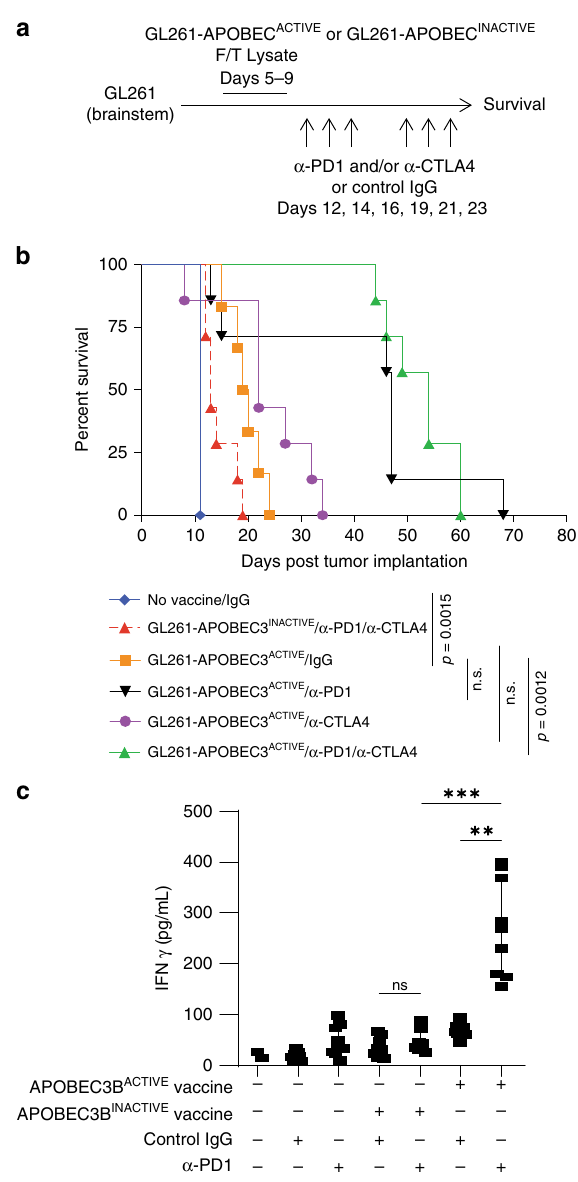
Fig. 3 APOBEC3B-modi fi ed GL261 cell lysate vaccine also effective against orthotopic gliomas. a Treatment strategy from (Fig. 2a) was adapted to target GL261 murine gliomas. In summary, on day 0, 5 × 10 4 GL261 murine glioma cells were implanted into the brainstem of C57Bl/6 mice. One 5-day course of APOBEC3B ACTIVE or APOBEC3B INACTIVE - modi fi ed GL261 cell vaccines (freeze/thaw lysate of 10 6 cells i.p.) was administered from days 5 to 9. This was followed by anti-PD1 antibody, anti-CTLA4 antibody or IgG control (12.5 mg/kg i.p.) on days 12, 14, 16, 19, 21, and 23. b Kaplan – Meier survival curves representing experiment described by ( a ) ( n = 7 mice/group). Representative of three separate experiments. Groups were compared using a Log-Rank test with Holm – Bonferroni correction for multiple comparisons. c Spleens and lymph nodes obtained from mice treated with GL261-APOBEC3B ACTIVE vaccination and/or antibody-mediated checkpoint inhibition were made into single-cell suspensions and cocultured with GL261 target cells for 72 h. Supernatant from the coculture was assayed using a mouse interferon gamma ELISA. ANOVA was used followed by Tukey ’ s multiple comparison test. Data points represent three separate biologic replicates. Error bars indicate mean and SD. ** p ≤ 0.01, *** p ≤